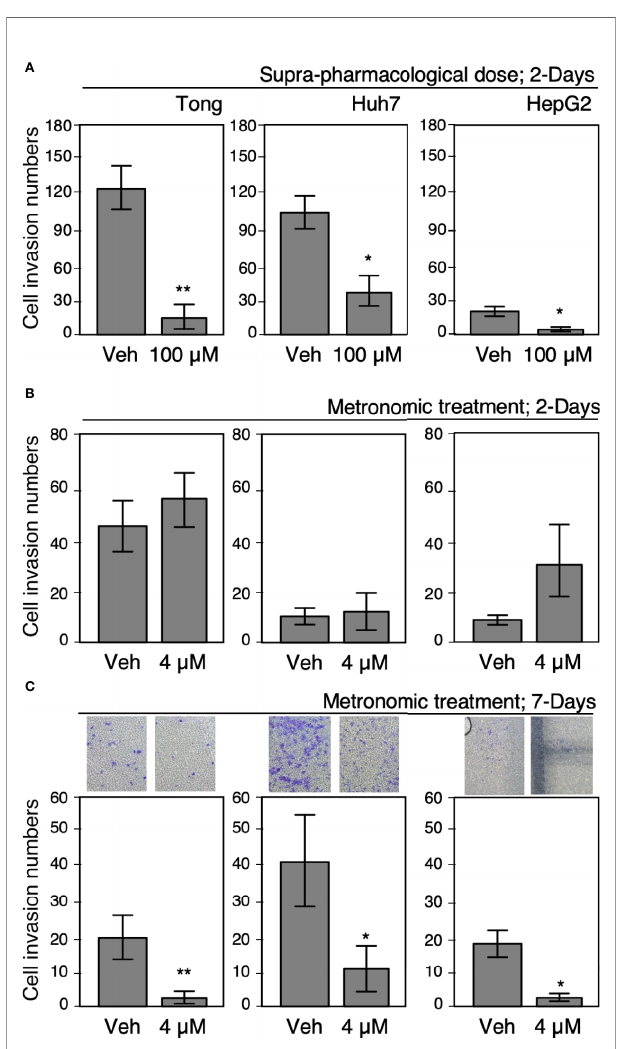
FIGURE 2 | Metronomic Celecoxib treatments reduced HCC cell invasion. (A) Suprapharmacological Celecoxib treatments (100 m M) on human HCC cells (Tong, Huh7, and HepG2) for 2 days suppressed cell invasion. (B) Clinically available Celecoxib treatments (4 m M) for 2 days did not suppress cell invasion. (C) Metronomic Celecoxib treatment (4 m M, 7 days) could suppress cell invasion in the HCC cells. The HCC cells treated with or without Celecoxib were plated onto Matrigel-coated transwells, incubated for 18 h to observe cell invasion, and recorded as corresponding photos. The data were from at least three reproducible independent experiments in which the raw invasive cell numbers were counted, and mean values with standard errors were plotted graphically. * Indicates P < 0.05 and ** indicates P < 0.01.